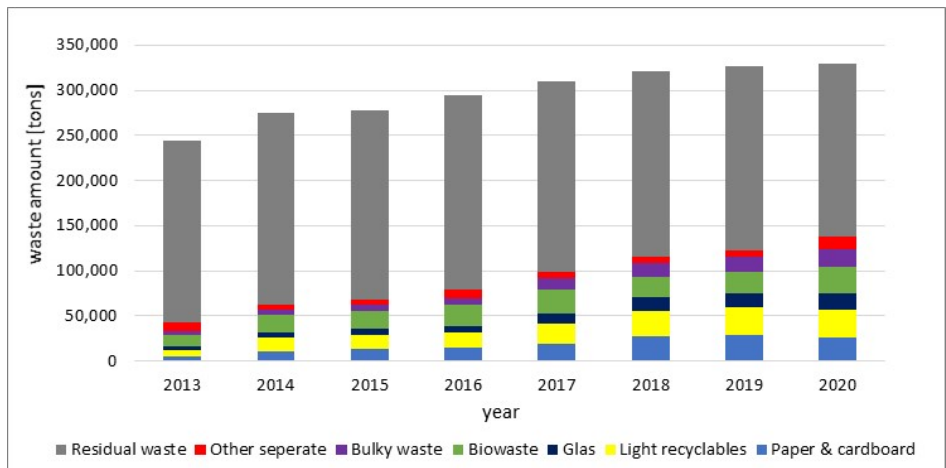
Figure 2. Results of municipal waste collection in Wroc ł aw in the period 2013–2020.